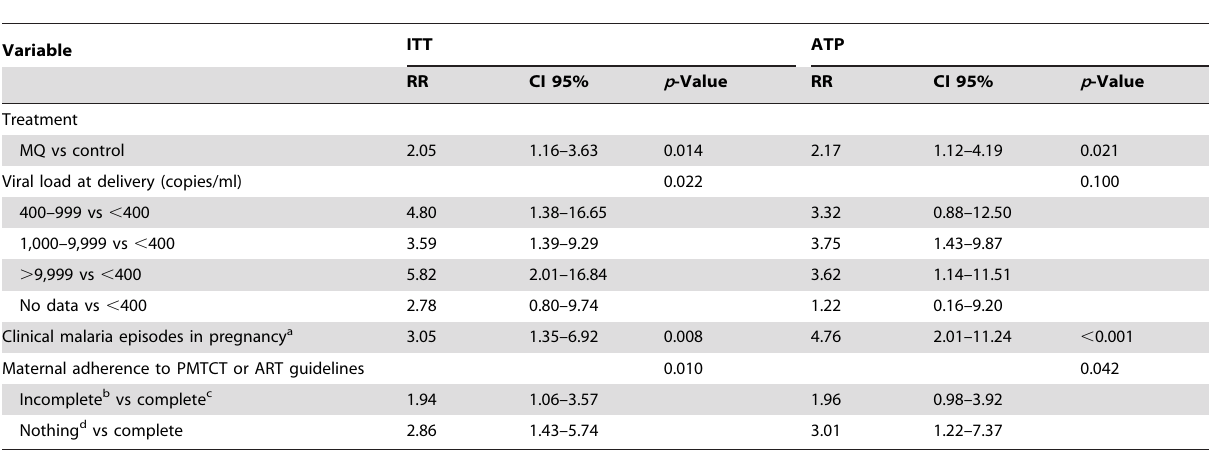
Table 12. Multivariate analysis of risk factors for mother to child transmission of HIV.